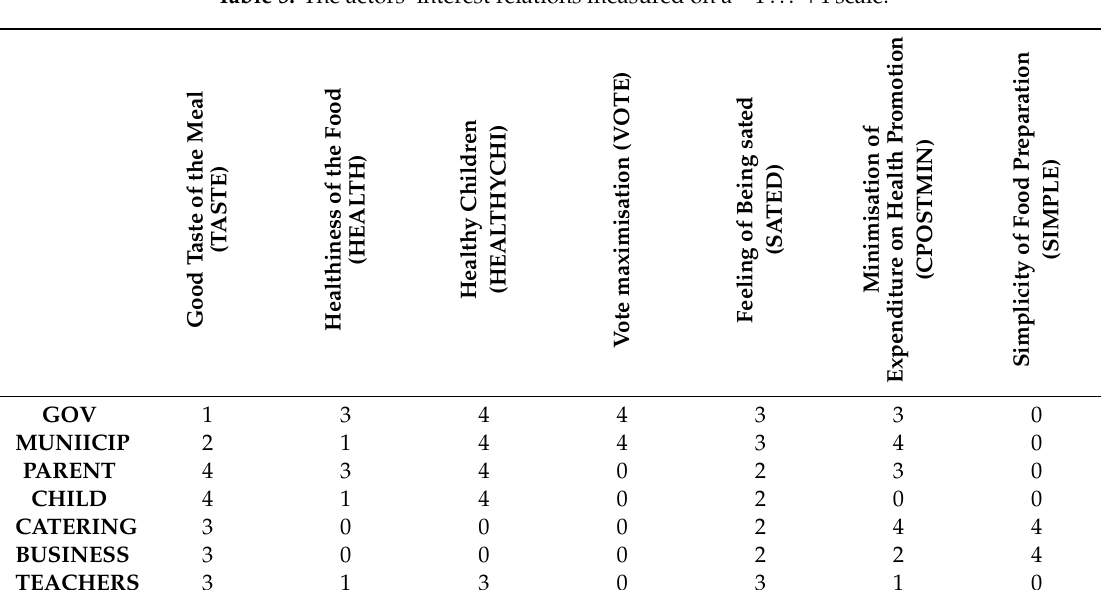
Table 5. The actors’ interest relations measured on a − 4 ... + 4